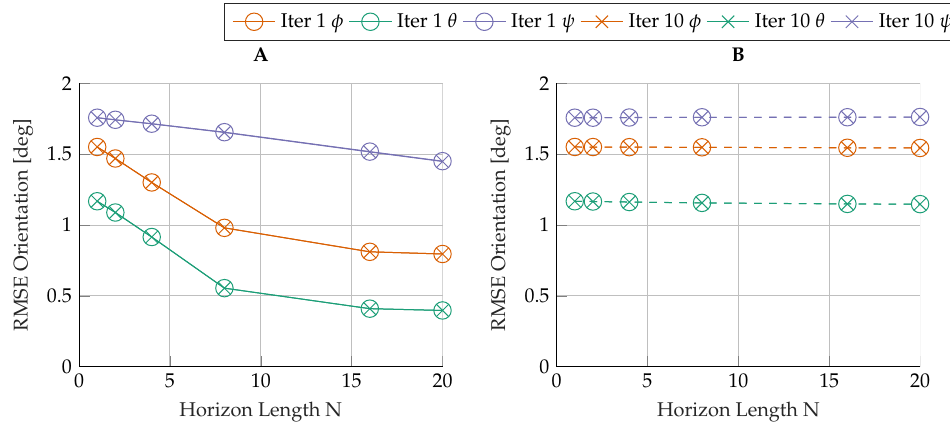
Figure 10. RMSE error in orientation for a different number of iterations I = { 1,10 } . The lagged solutions are plotted on the left ( A ) and the real-time solutions on the right ( B